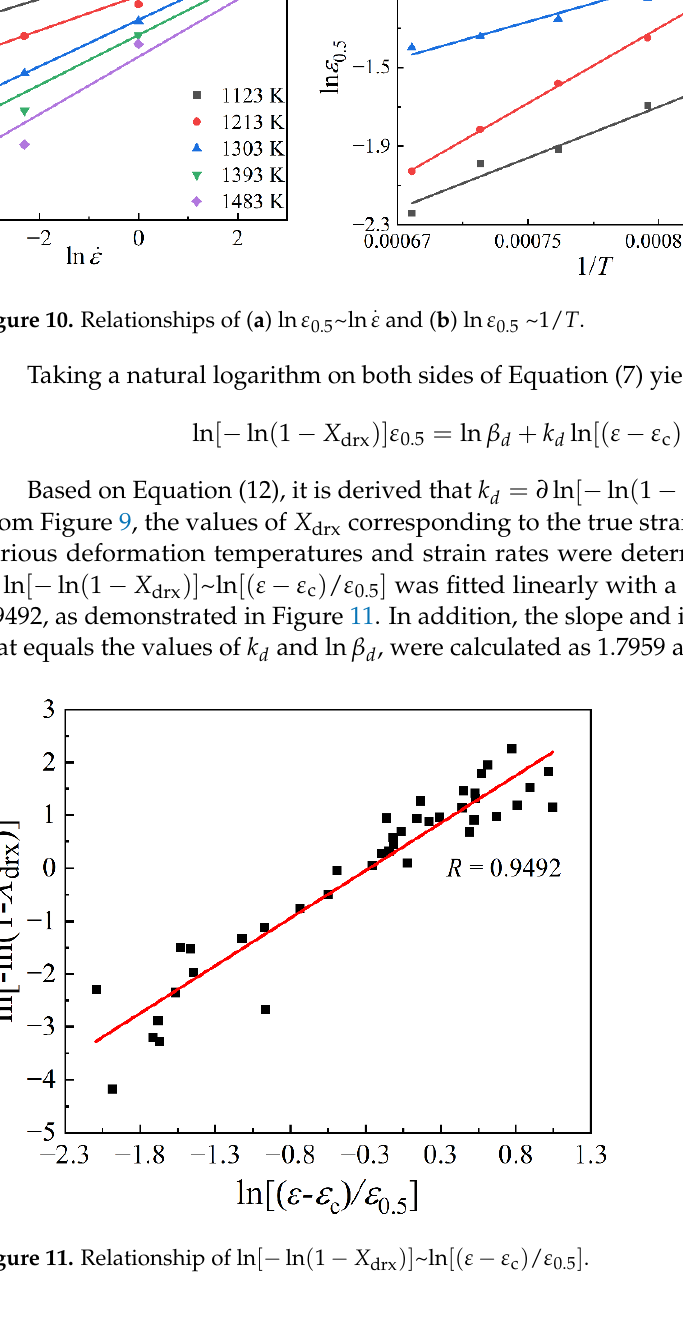
Figure 11. Relationship of ln [ − ln ( 1 − X drx )] ~ln [( ε − ε c ) / ε 0.5 ] . Therefore, the DRX kinetics models for SAE 5137H steel can be summarized as Equa- tion (13):